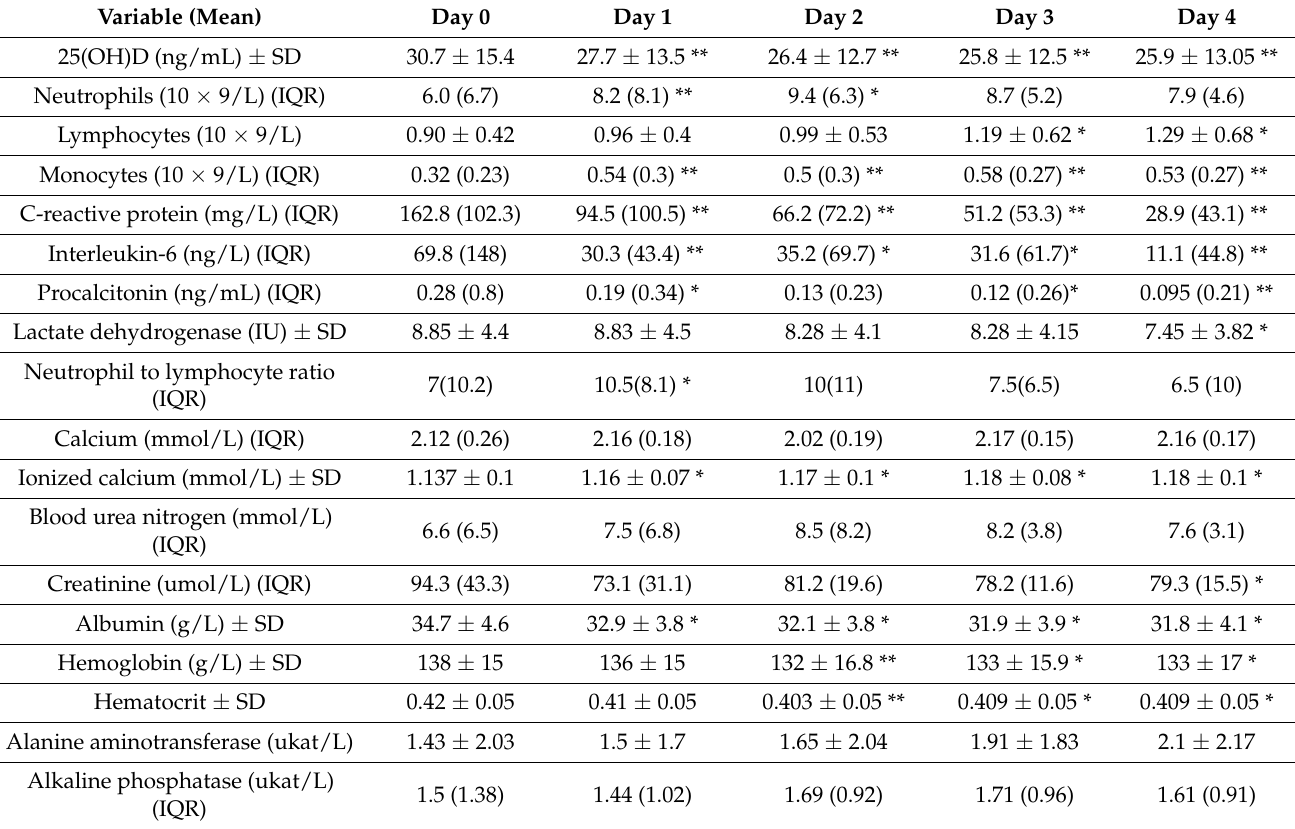
Table 3. The changes in concentration of all parameters during the monitoring period compared to the baseline value on day 0